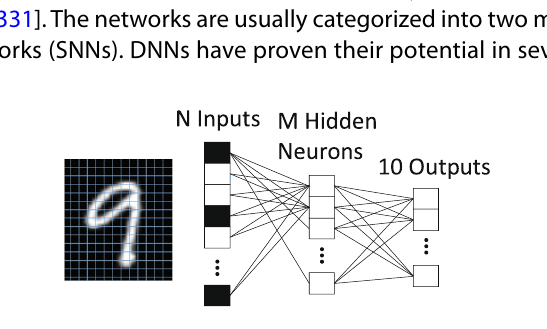
Fig. 27 An illustration of pattern recognition for the case of handwritten digits recognition. The image is divided into N small clusters (i.e. N input elements) with all elements connected into a hidden neuron layer of size M, and those hidden neurons are then connected to the 10 output neurons, representing the digits 0–9. Reproduced with permission [297]. Copyright 2017,